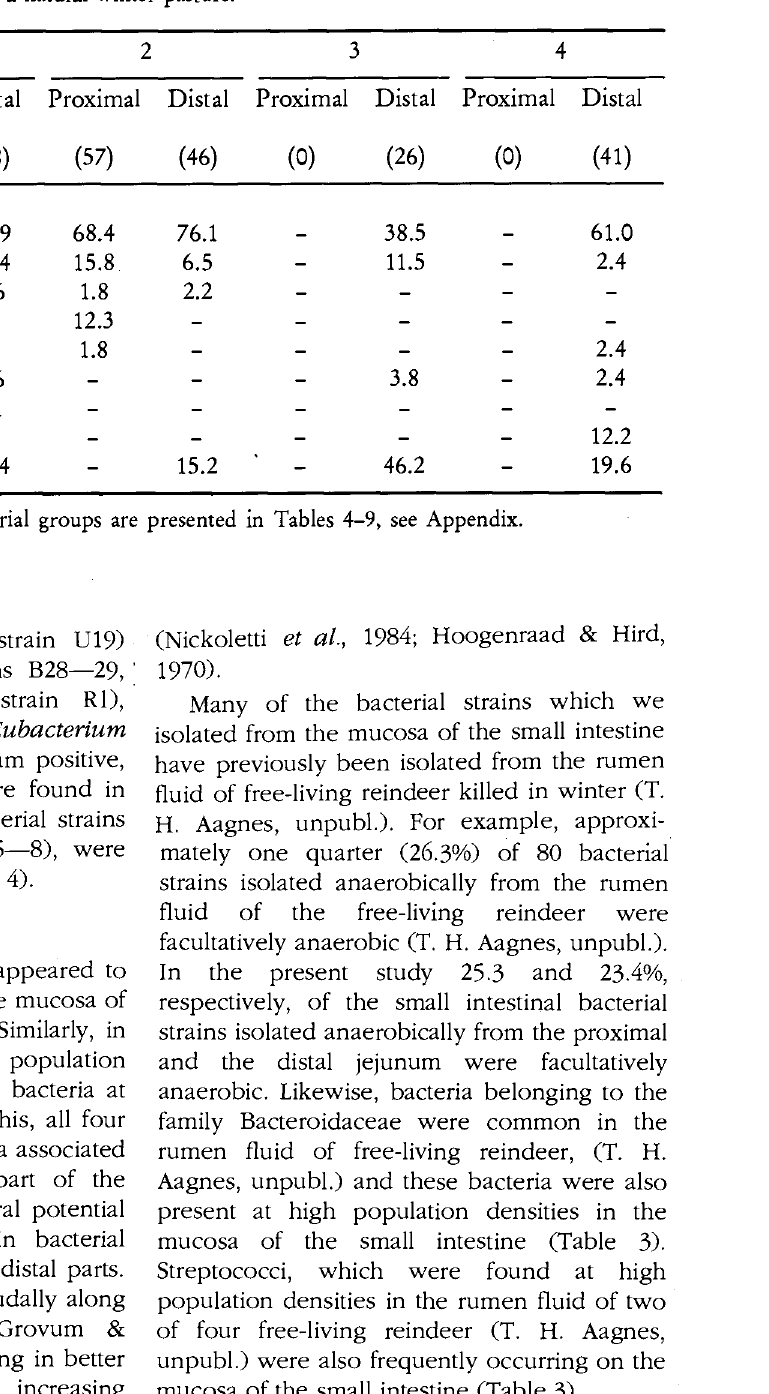
Table 3. Proportion (%) of different types of bacteria isolated from the mucosa in the proximal and distal jejunum of free-living reindeer grazing on a natural winter pasture. Reindeer number Site of isolation in jejunum